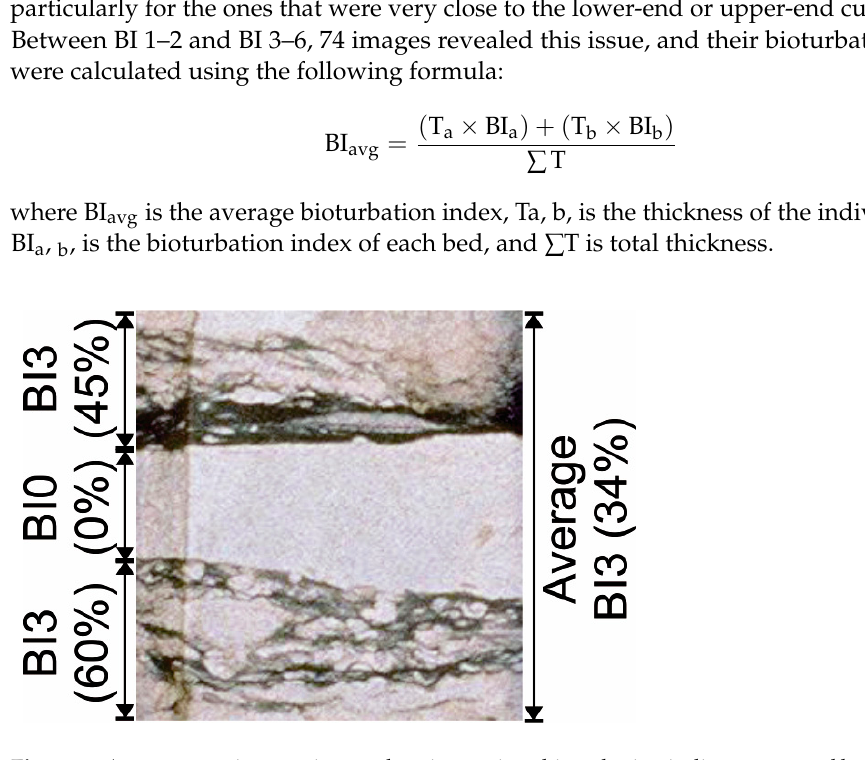
Figure 1. A representative core image showing various bioturbation indices expressed by bioturbation index (BI) in different facies.